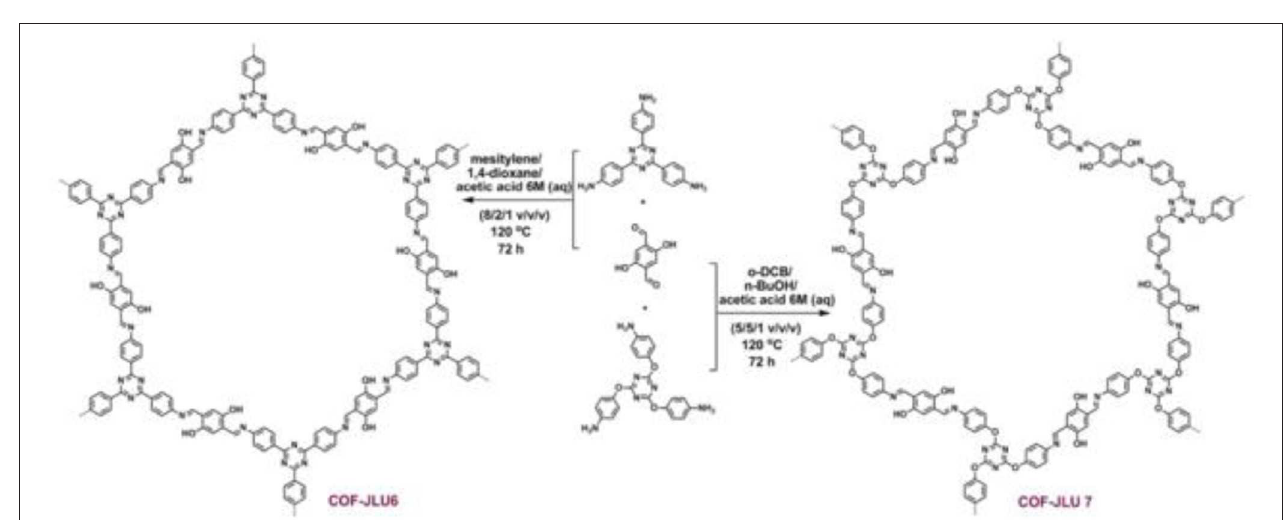
FIGURE 22 | Synthesis and resulting structure of COF-JLU6 and COF-JLU7. Reprinted with permission © 2017 The Royal Society of Chemistry.